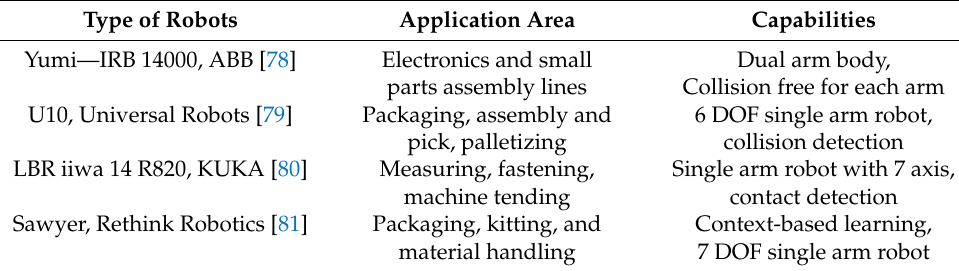
Table 2. Types of collaborative robotic systems in industrial